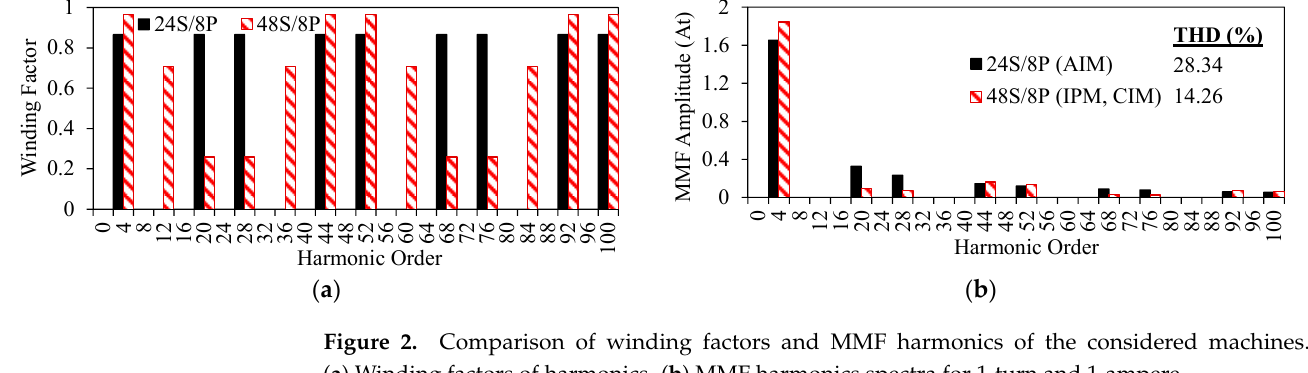
Figure 2. Comparison of winding factors and MMF harmonics of the considered machines. ( a ) Winding factors of harmonics. ( b ) MMF harmonics spectra for 1-turn and 1-ampere.